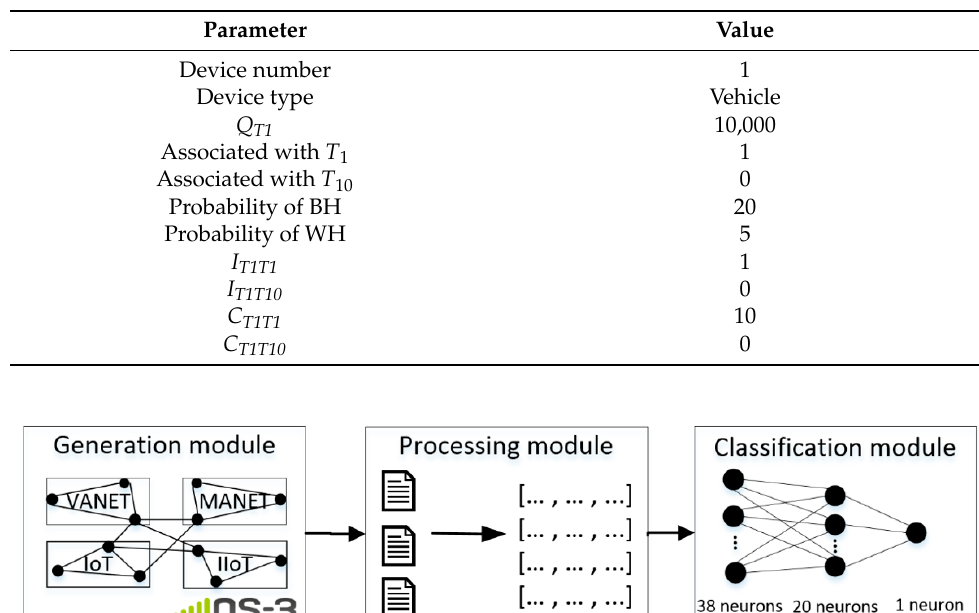
Table 3. Vector example.